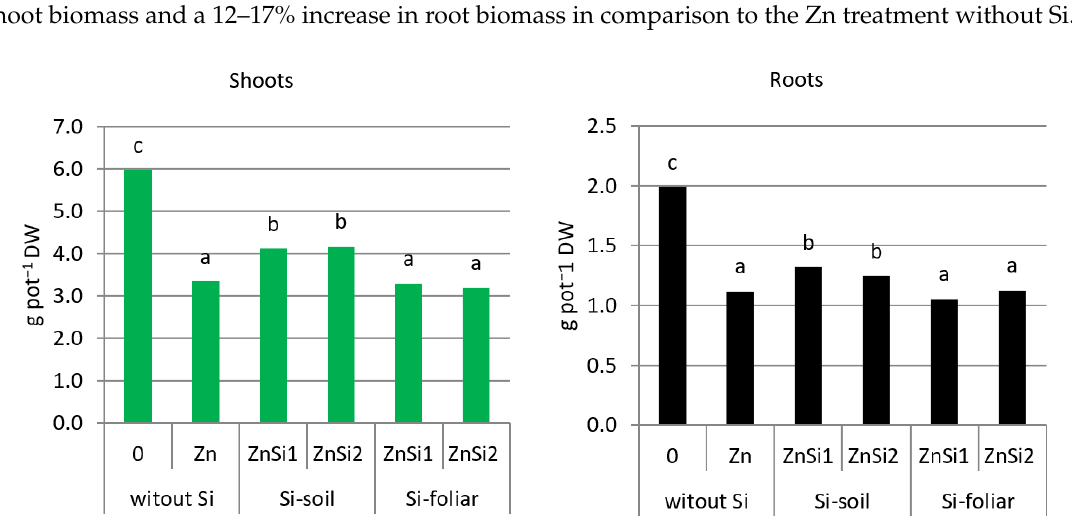
Figure 1. Biomass of wheat shoots and roots. Values marked with the same letters indicate no significant difference according to Tukey ’ s test ( p < 0.05).